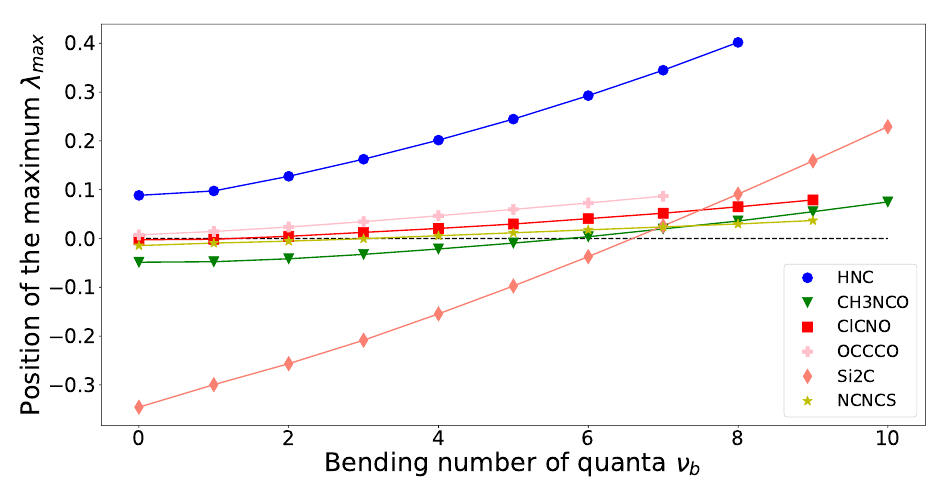
Figure 4: Position λ where the QFS takes its maximum value for each state with (cid:96) = 0 of selected bending degrees of freedom for HNC (blue), CH NCO (dark-green), 3 37 ClCNO (red), OCCCO (pink), Si C (coral) and NCNCS (olive), versus the bending 2 quantum number ν . The dashed black horizontal line marks the λ = 0 b